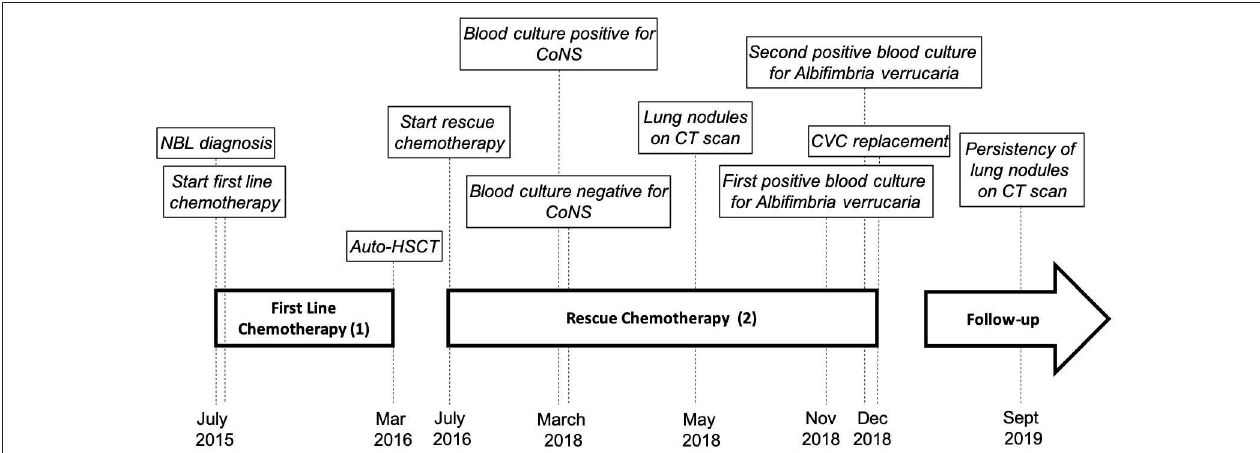
FIGURE 1 | Patient medical history timeline. (1) First-line chemotherapy: SIOPEN NB-HR-01 protocol consisting of 10 weeks of induction chemotherapy (COJEC scheme), surgery on the primary tumor, auto HSCT with Busulfan and Melphalan, 21 Gys of radiotherapy, and six courses of anti-GD2 antibody. (2) Rescue therapy: